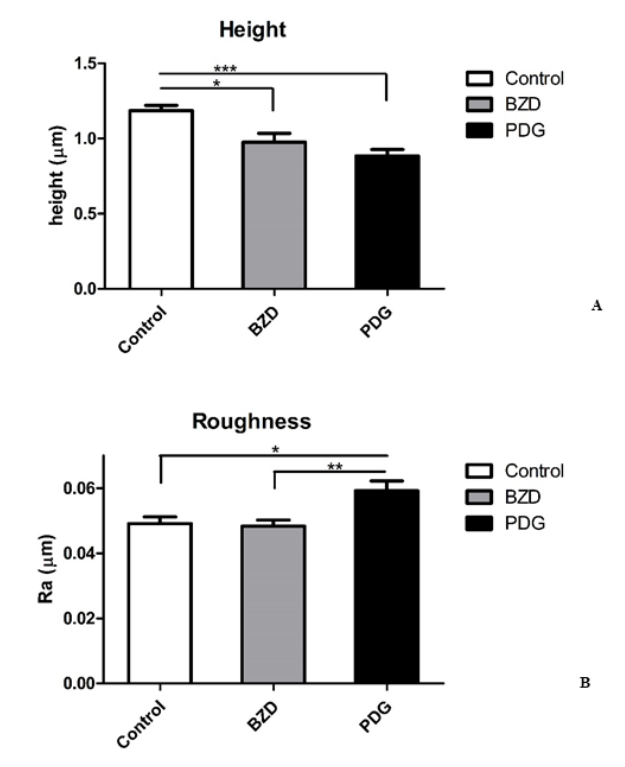
Figure 4. (A) Average height in micrometers, for the different formulations tested and surface scans. Bars represent the standard deviation of the mean of at least 30 measurements. *, P < 0.05; ***, P < 0.001. (B) Surface roughness (Ra) in micrometers, for the different formulations tested and surface scans. Bars represent the standard deviation of the mean of at least 30 measurements. *, P < 0.05; **, P <